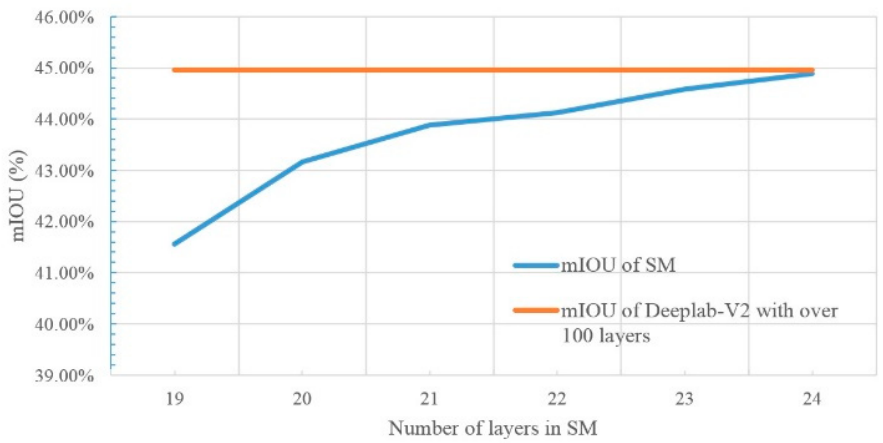
Figure 7. The changes in accuracy upon increasing the depth of SM.